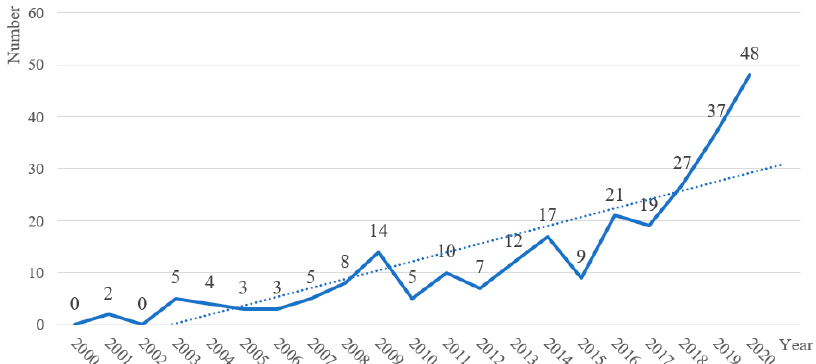
Figure 3. Distribution of related papers from 2000 to 2020.